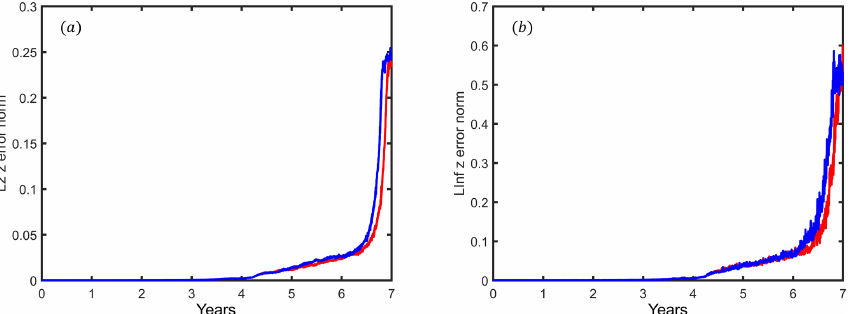
Figure 2. Geopotential height error norms of SWTC2. (a) L 2 error norm; (b) L ∞ error norm. The results of RK4 and NRK4 are represented by blue and red lines, respectively. The model mesh is x1.2562.